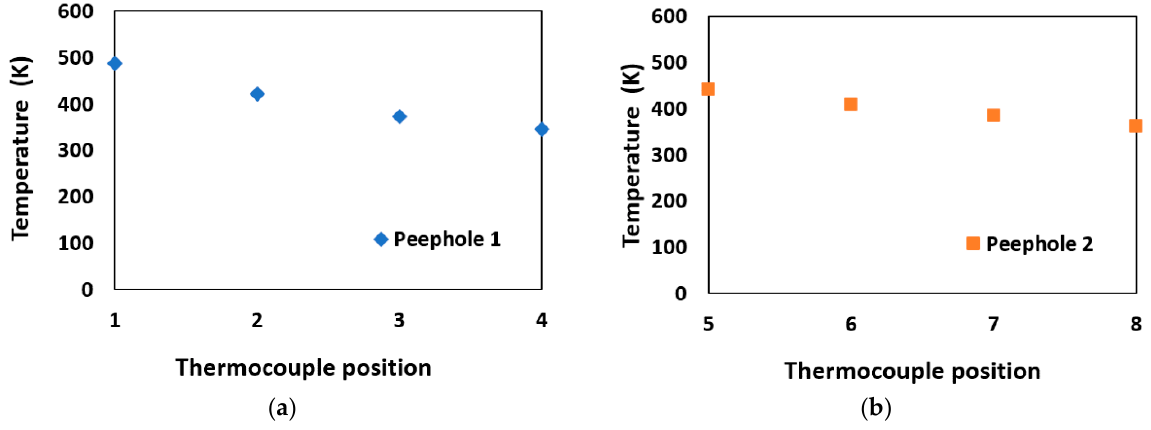
Figure 18. Average temperature measurements at each thermocouple position: ( a ) peephole 1; ( b ) peephole 2.